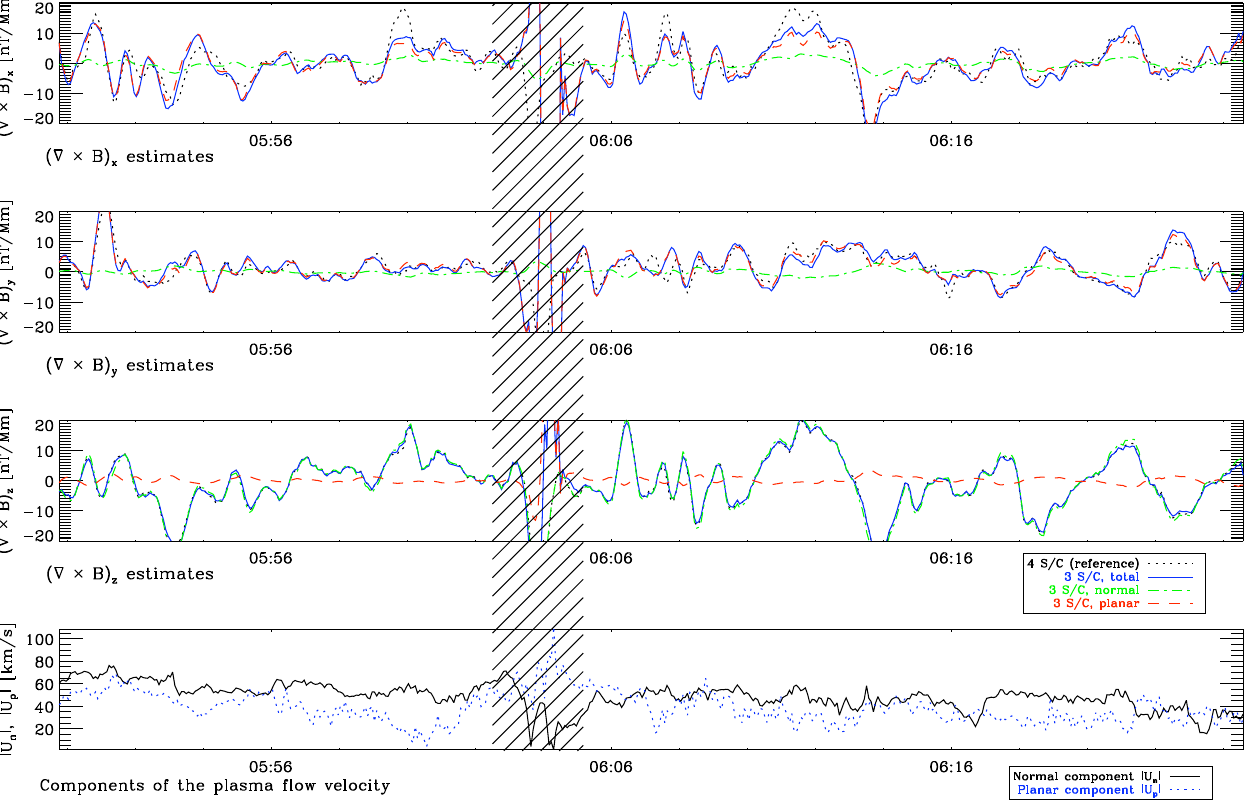
Fig. 1. 4 February 2001, 05:50–06:25UT: GSE components of ∇ × B (first three upper panels) as well as normal and planar components of the plasma flow velocity (lowest panel). Shown are profiles that have been averaged over 20s. The estimates obtained using our three-point method with the stationarity assumption (solid blue line) are compared against the four-point estimates (dotted black line). The normal component ( ∇ × B ) n (Eq. 25) and the planar component ( ∇ × B ) p (Eq. 26) of the curl with respect to the three-spacecraft plane are also given (dot-dashed green line and dashed red line, respectively). A significant mismatch of the three-point and four-point estimates occurs around 06:03 UT when the normal plasma flow speed takes very small